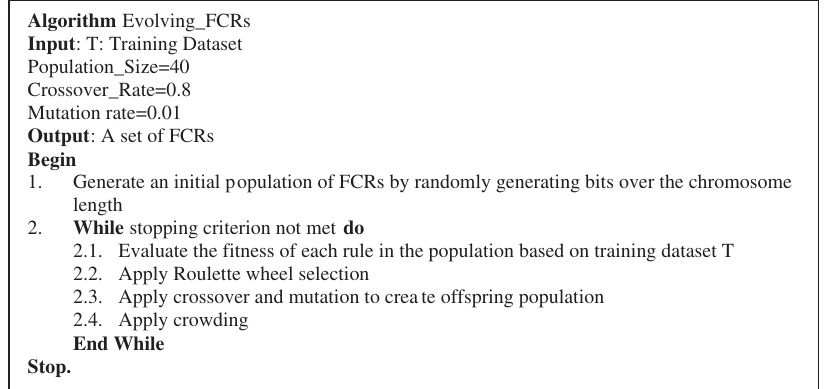
Algorithm Evolving_FCRs Input : T: Training Dataset